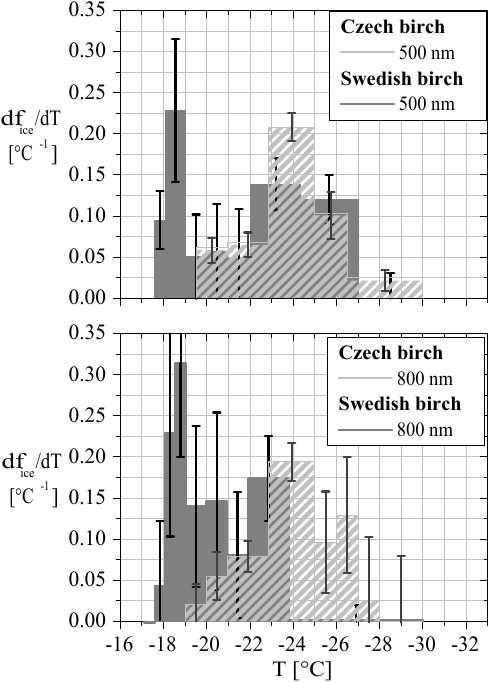
Fig. 9. Change of the ice fraction f ice per temperature interval for the 500 (upper panel) and 800nm (lower panel) particles of the Czech birch pollen washing water (light gray) and the Swedish birch pollen washing water (dark